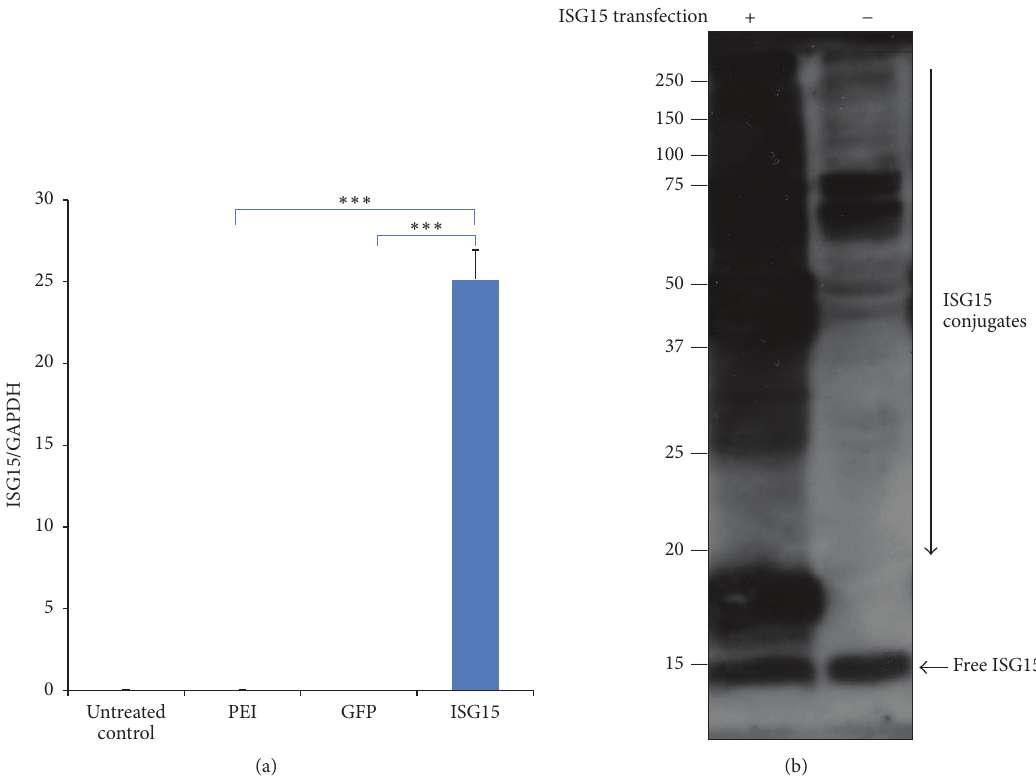
Figure 1: ISG15 expression and ISGylation were increased by transfection . HepG2.2.15 cells were transfected with the ISG15 expression plasmid or GFP-expressing plasmid. (a) Levels of ISG15 mRNA were determined by real-time PCR (normalized by GAPDH) 24 hours after transfection. PEI, transfection regent polyethyleneimine (PEI) treatment only; GFP, transfected with 4 𝜇 g GFP-expressing plasmid; ISG15, transfected with 4 𝜇 g ISG15 plasmid. The results are presented as the means ± SD, 𝑛 ≥ 3 ; error bars indicate SD. ∗∗∗ 𝑃 < 0.001 . (b) Protein ISGylation was further assessed by western blot with or without ISG15 overexpression. Molecular mass markers are shown on the left